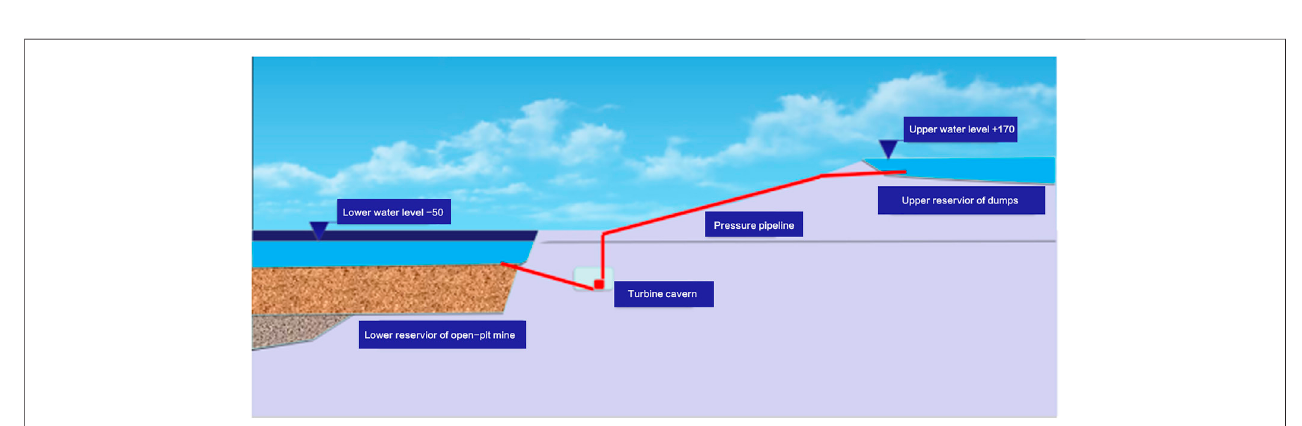
Frontiers in Earth Science |